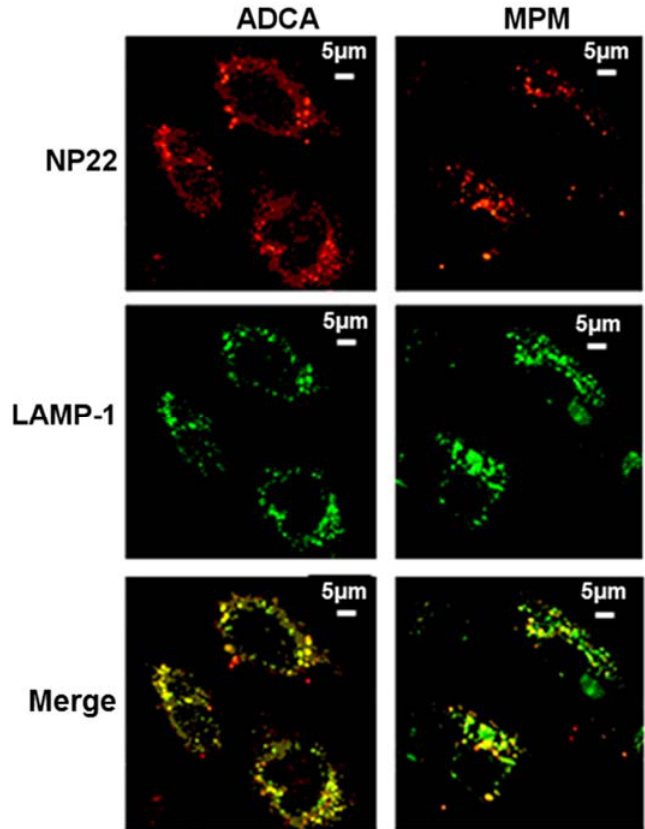
Figure 2. Co ‐ localization of fluorescent NP 22 in intracellular acidic compartments of lung adenocarcinoma and mesothelioma cells. Line 1: localization of nanoparticles (NPs), line 2: LAMP ‐ 1 labelling of acidic compartments, line 3: Merge picture of line 1 and 2. Yellow color indicates a co ‐ localization between NPs and acidic vesicles.